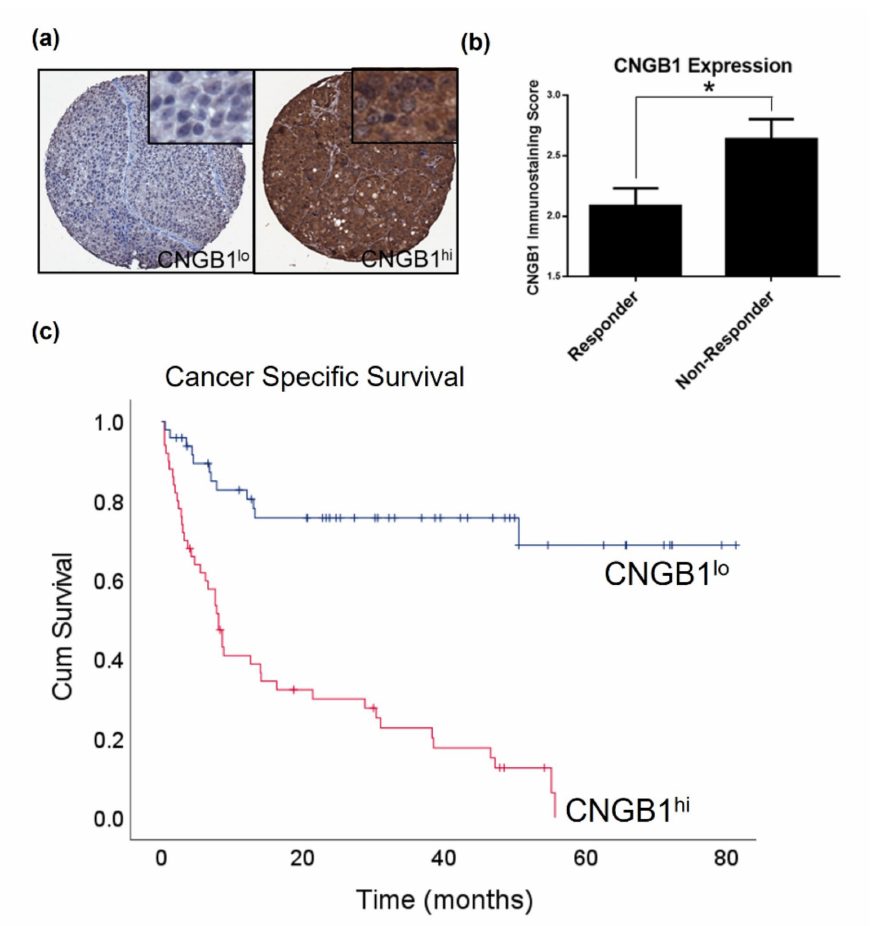
Figure 4. CNGB1 is upregulated in ‘Non-Responders’ to NAC and associates with MIBC patient survival. ( a ) Examples of low (CNGB1 lo ) and high (CNGB1 hi ) levels of CNGB1 expression in MIBC patient tissue cores. ( b ) Comparison of CNGB1 immunostaining score between ‘Responder’ and ‘Non-Responder’ patients, a protein-based validation of the Discovery cohort ( n = 30, t -test, * p < 0.05). ( c ) Correlation of CNGB1 expression with cancer specific survival by Kaplan-Meier analysis (Validation cohort 2; n = 99, Log rank test, p <